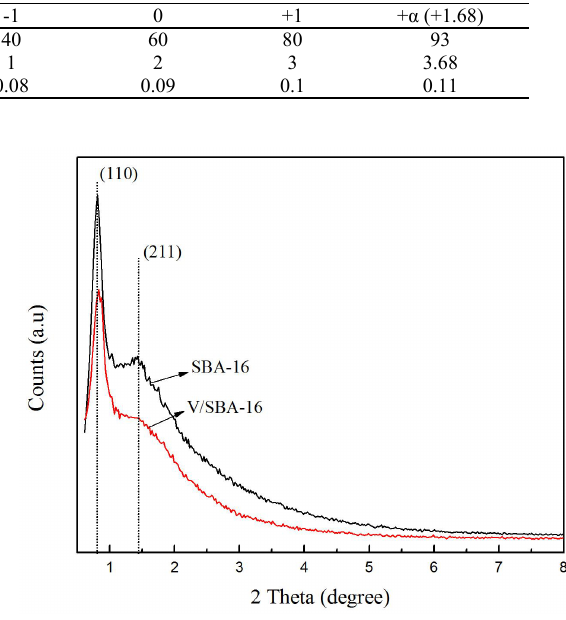
Fig. 2. Low-angle XRD patterns of SBA-16 and V/SBA-16